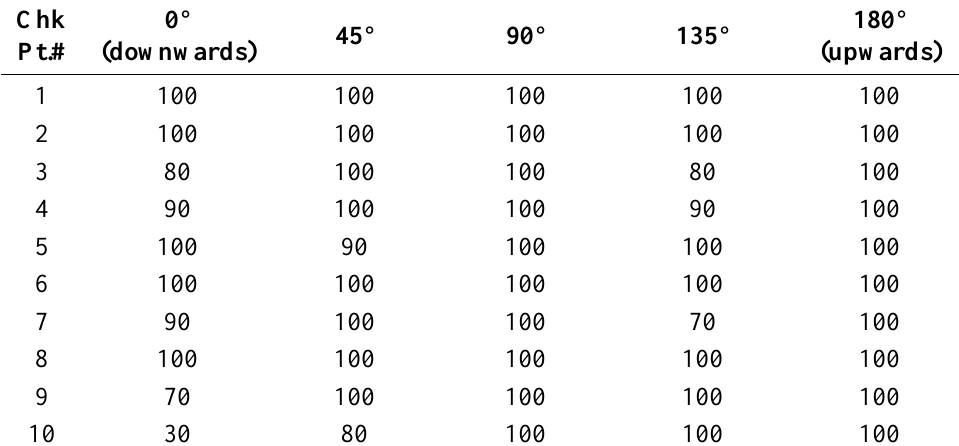
Table 4. Percentage of detected signals for different speaker orientations. First column contains the check point number. Columns 2, 3, 4, 5, and 6 contain the percentage of detected signals for each angle at which the phone was